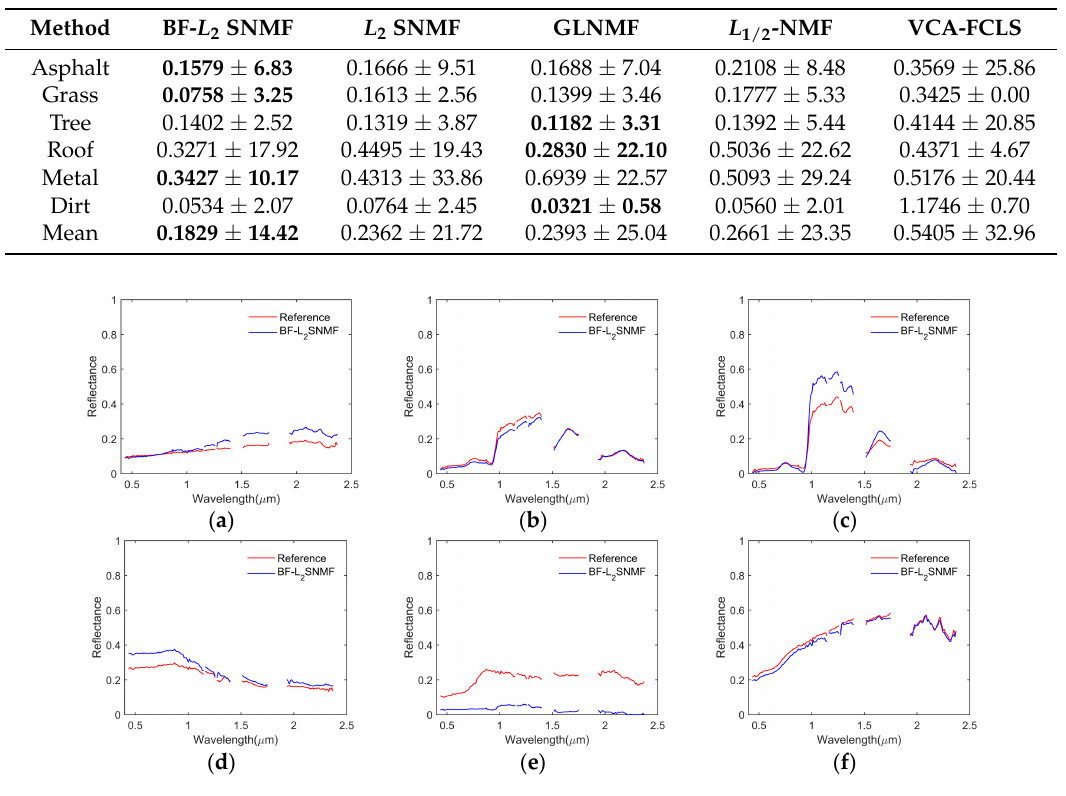
Figure 8. The comparison of the reference spectrum and the estimated endmember signals obtained by BF- L 2 SNMF on the urban data set: ( a ) asphalt, ( b ) grass, ( c ) trees, ( d ) rooves, ( e ) metal, and ( f ) dirt.